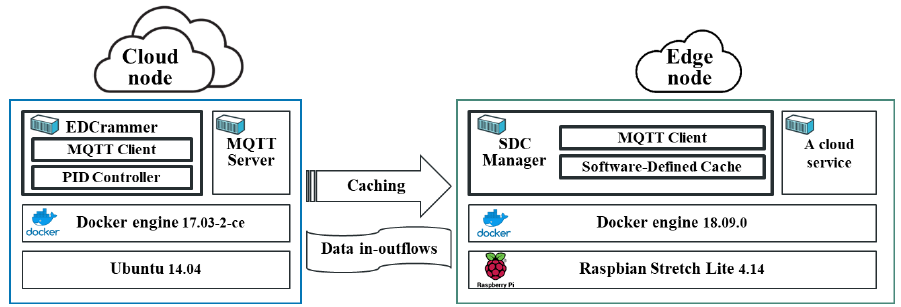
Figure 7. Performance evaluation environment for EDCrammer-based caching. Table 2. Specifications for the cloud and edge nodes used in the performance